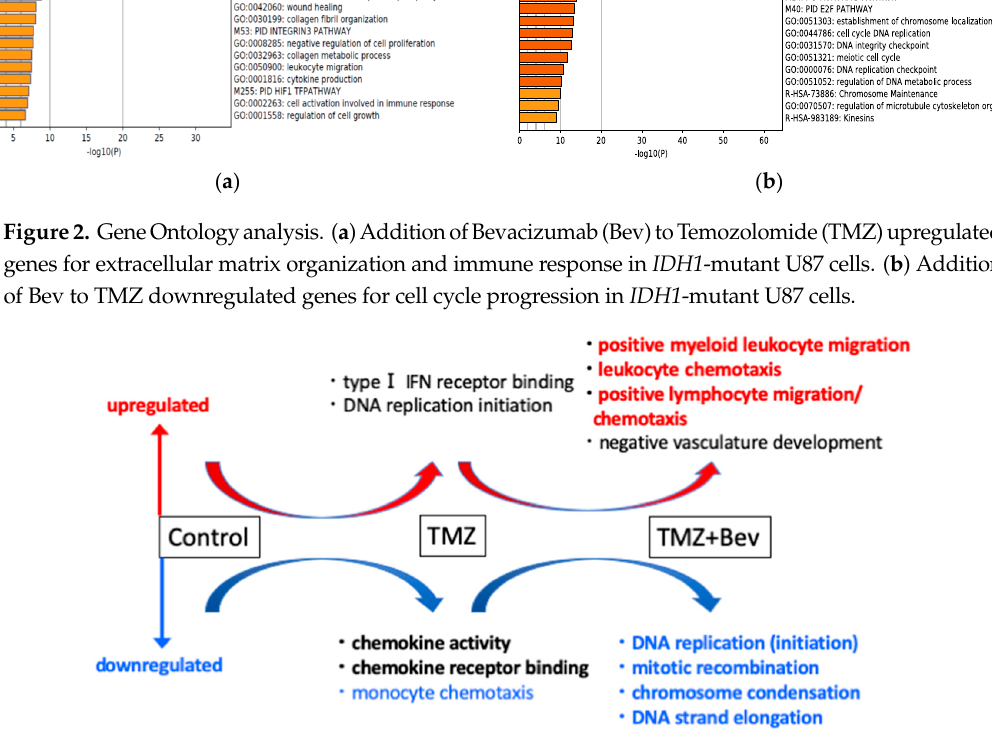
Figure 3. Gene Set Enrichment Analysis (GSEA) suggested that the combination of Bevacizumab and Temozolomide activated genes related to immunocyte migration (myeloid leukocyte migration, leukocyte chemotaxis, and lymphocyte migration / chemotaxis), but suppressed genes related to the cell cycle (DNA replication, mitotic recombination, chromosome condensation, and DNA strand elongation) in IDH1 -mutant U87